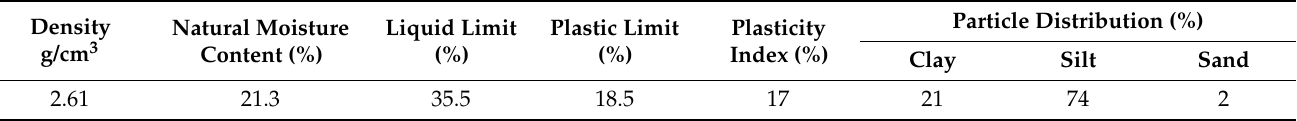
Table 1. Physical properties of soil used in laboratory testing (before